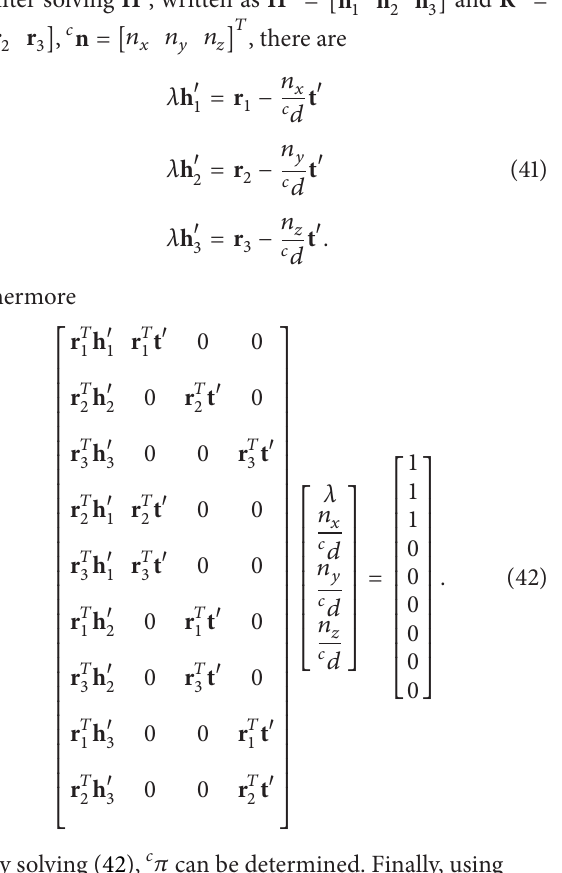
Figure 5: Scheme of static look-and-move